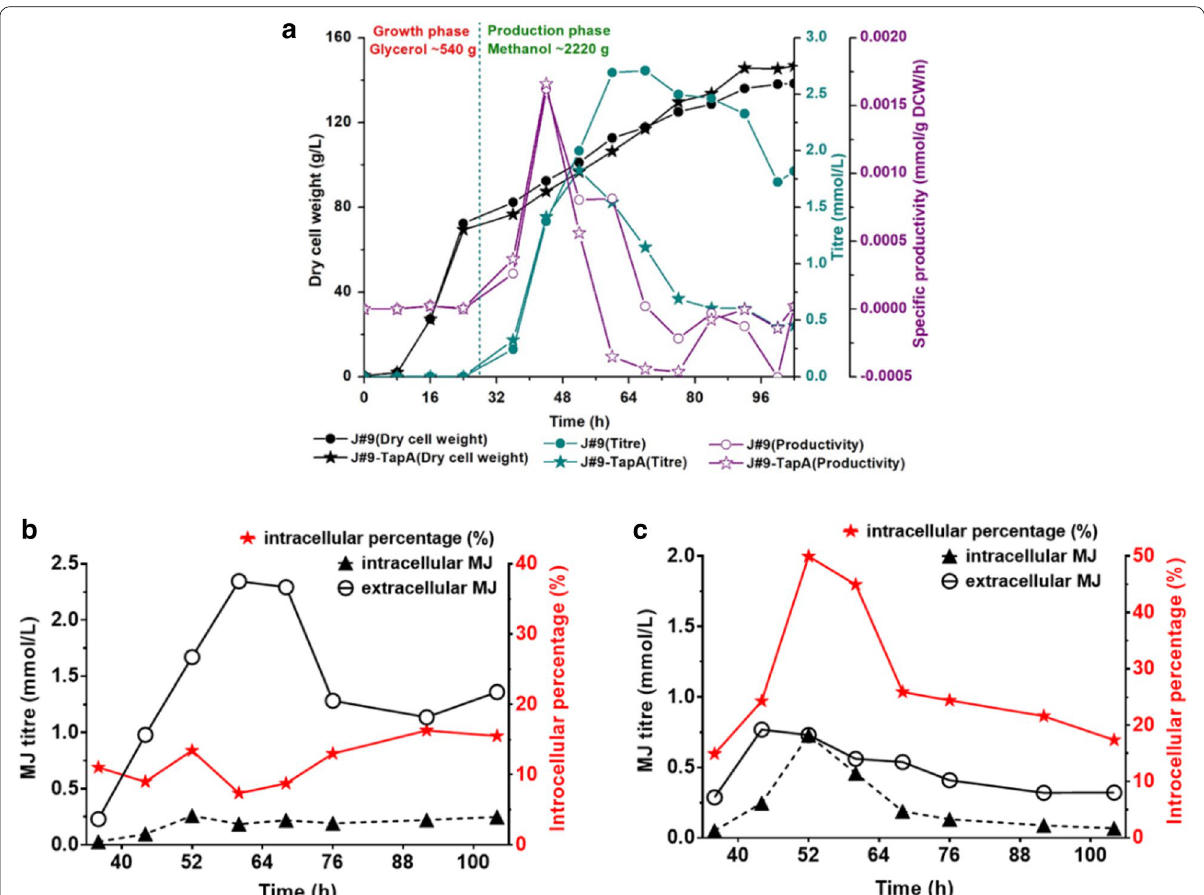
Fig. 4 Evaluation of TapA function and MJ production of J#9-TapA and J#9 in bioreactor. a Time profiles of J#9-TapA and J#9 fermentation in a 5-L stirred tank bioreactor. Broth samples (2 mL) were collected at 8-h intervals and were analyzed twice to quantify cell growth and MJ concentration. Culture methods kept the same for both strains. Extracellular MJ level, intracellular MJ level and intracellular MJ percentage in strains of J#9 ( b ) and J#9-TapA ( c ). The bioreactor fermentation experiments were conducted two